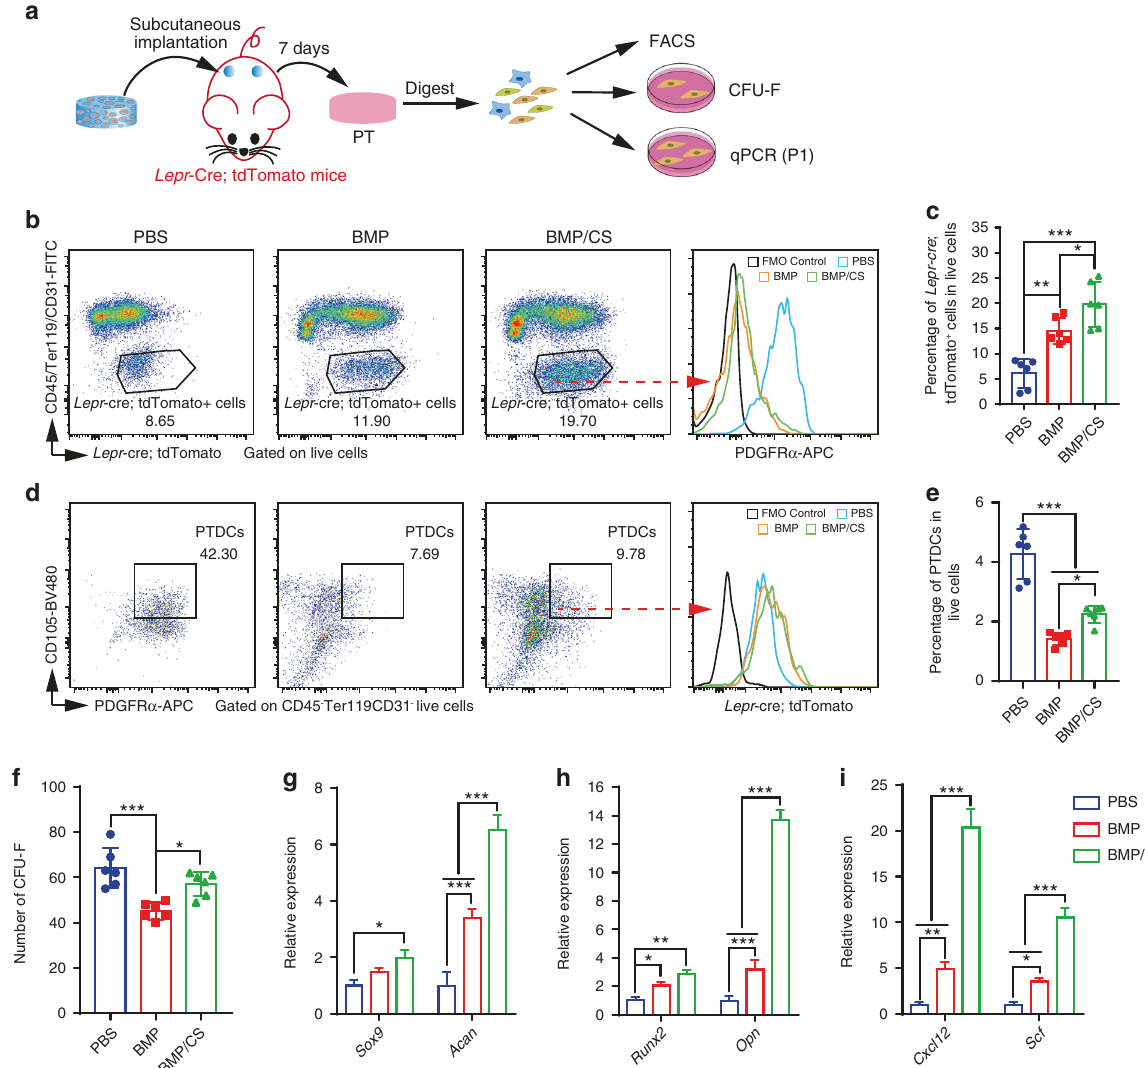
Fig. 2 Functional PTDCs are lodged in PTs. a Scheme of the experiments for evaluating the function of PTDCs in PTs from the PBS, BMP, and BMP/CS groups. b – e Representative fl ow cytometric pro fi les and quantitative analysis of Lepr -cre; tdTomato + cells ( b , d ) and PTDCs (CD45 − Ter119 − CD31 − CD140a + CD105 + ; c , e ) from the PBS, BMP, and BMP/CS groups 1 week after subcutaneous implantation in Lepr -cre; tdTomato mice ( n = 6). The Lepr -cre; tdTomato + cells and CD140a + CD105 + PTDCs were gated on CD45 − Ter119 − CD31 − live cells with the elimination of debris, dead cells, and doublets/cell aggregates. Data from individual animals are shown as the mean ± SD. * P < 0.05, ** P < 0.01, *** P < 0.001, one-way ANOVA followed by Tukey ’ s post hoc tests. f Number of colony-forming unit fi broblasts (CFU-Fs) per 1 × 10 4 enzymatically dissociated cells from the PBS, BMP and BMP/CS groups ( n = 6). Data from individual animals are shown as the mean ± SD. * P < 0.05, ** P < 0.01, *** P < 0.001, one-way ANOVA followed by Tukey ’ s post hoc tests. g – i qPCR analysis of the transcript levels of genes associated with chondrogenesis ( g ), osteogenesis ( h ), and stem cell maintenance ( i ) in PTDCs from PTs in the PBS, BMP, and BMP/CS groups ( n = 3). Total RNA was extracted from fi rst-passage PTDCs. Data from individual animals are shown as the mean ± SD. * P < 0.05, ** P < 0.01, *** P <